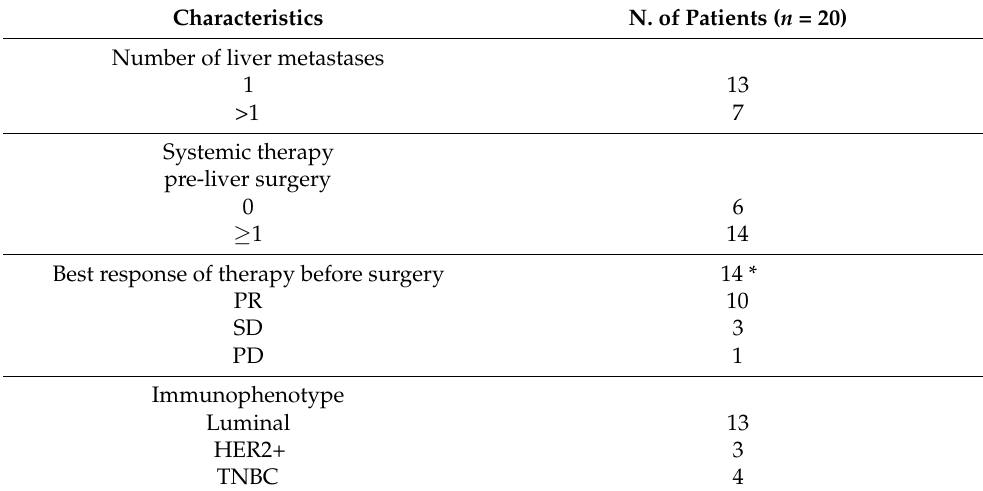
Table 2. Characteristic of patients with liver metastasectomy with negative resection margin